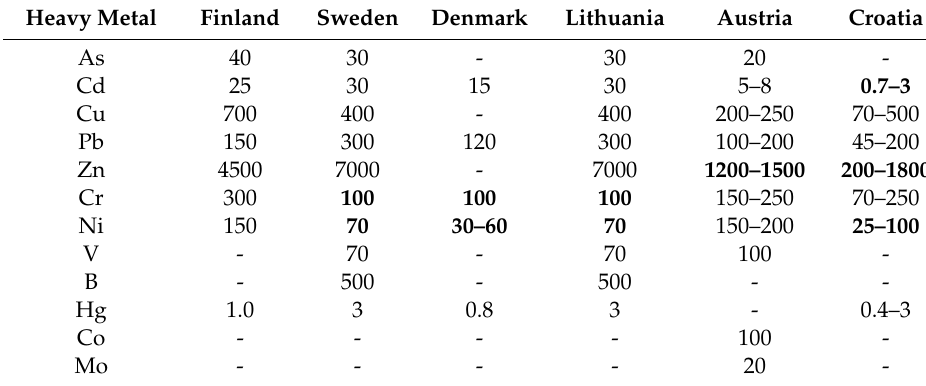
Table 5. Heavy metals concentration limit values for the use of WBA in agriculture and forestry [mg / kg]